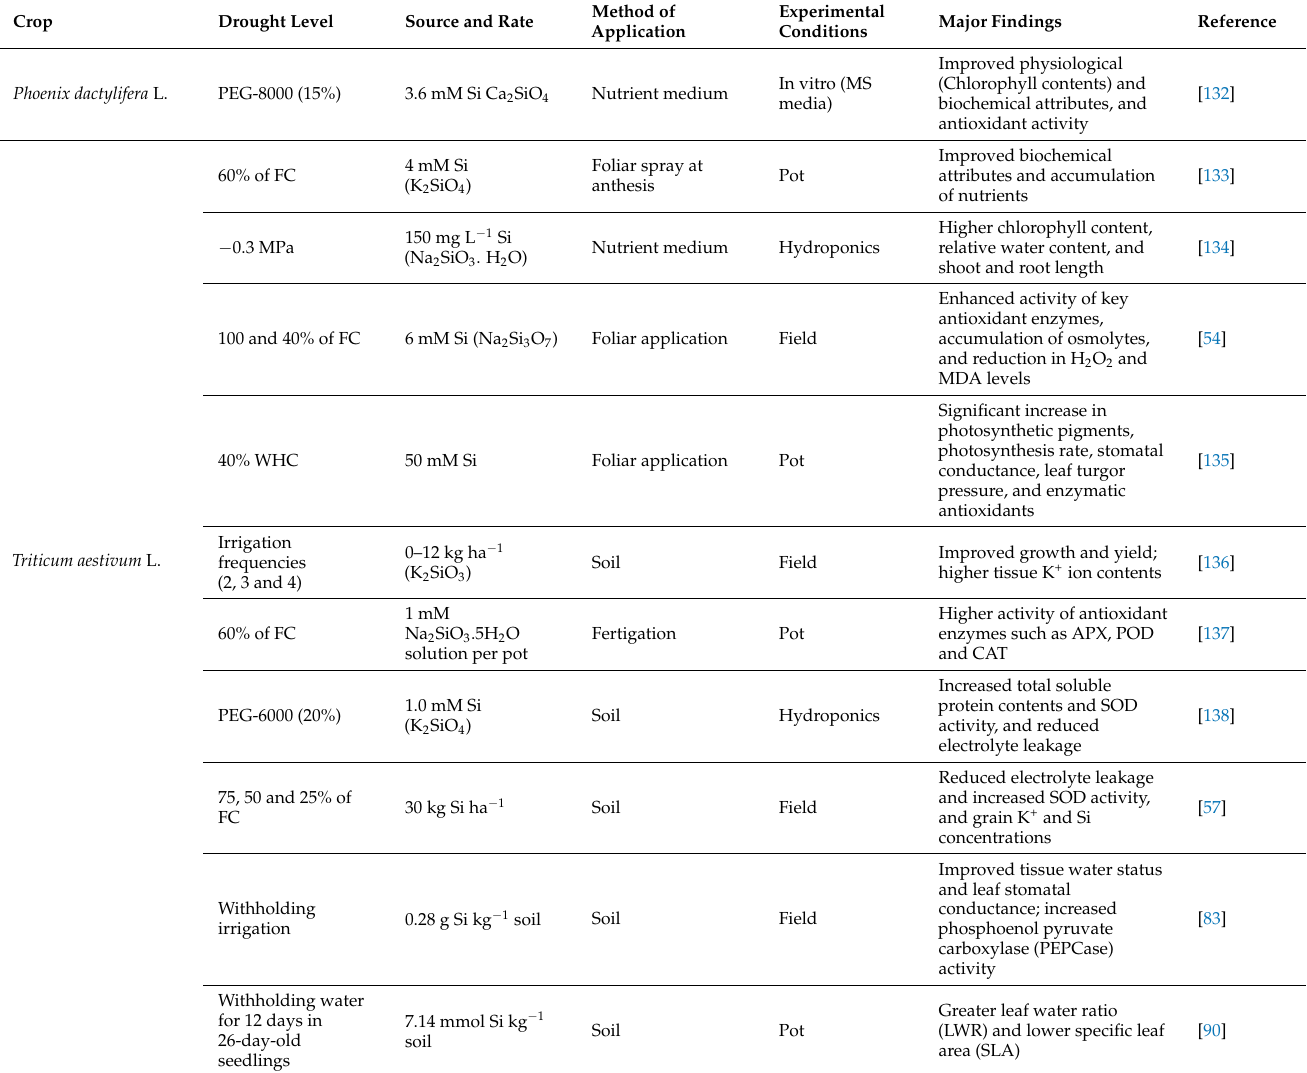
Table 1. Plant responses to Si nutrition under water-deficit